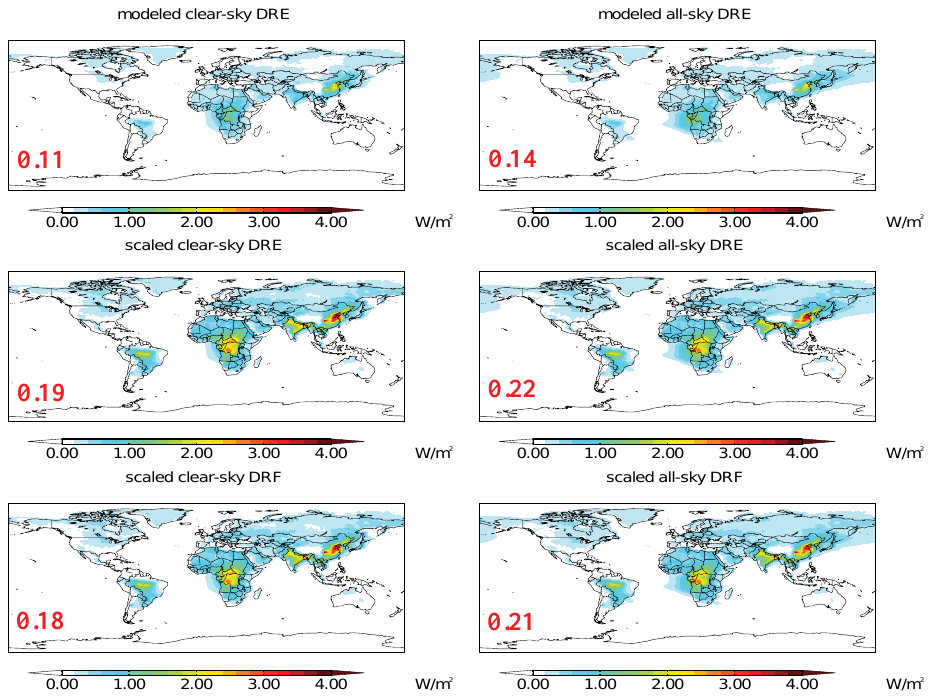
Figure 10. The global annual mean BC DRE at the top atmosphere (TOA) in the “best” model, scaled DRE and scaled DRF in 2010 at both clear-sky and all-sky conditions. Numbers in red indicate the global mean value.